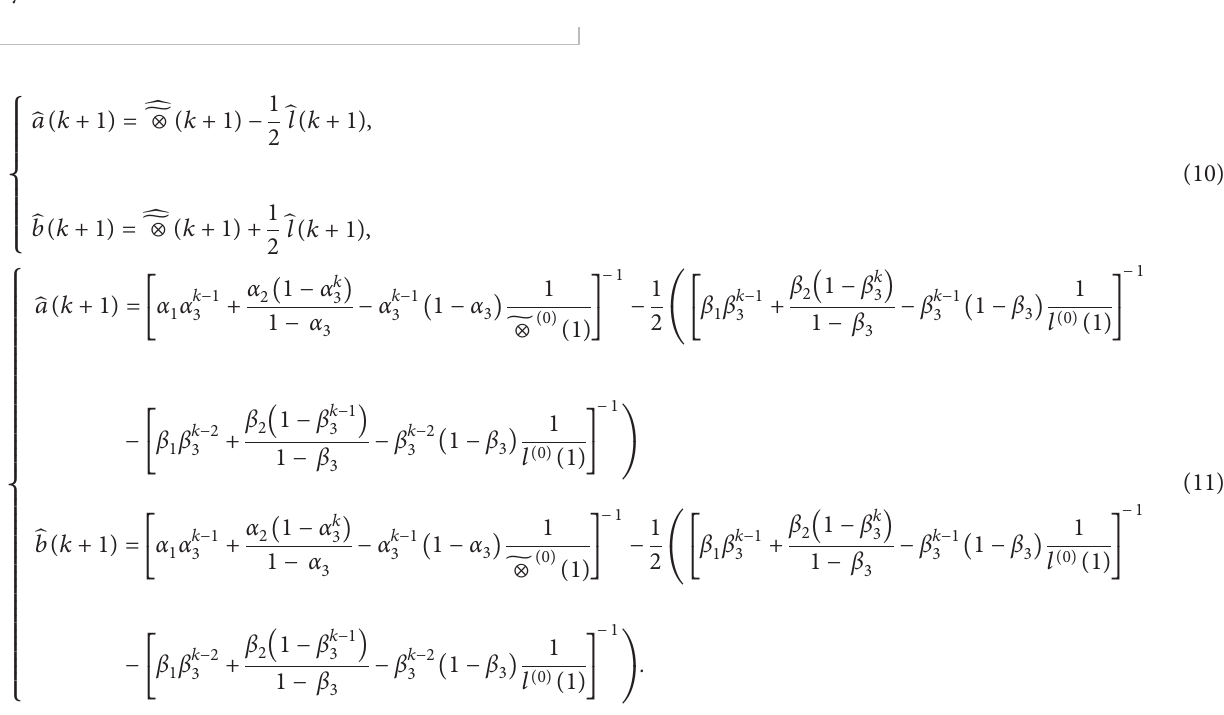
According to (5), the grey prediction model of upper and lower bounds of interval grey number 􏽣 ⊗ ( k + 1 ) ∈ [ 􏽢 a ( k ) , 􏽢 b ( k )] can be